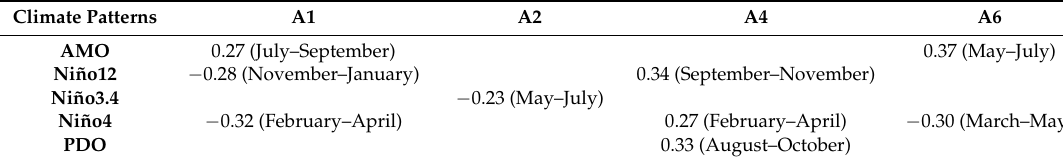
Table 1. Correlations of the identified climate patterns and the summer archetypes at 95% confidence level. The time period of the archetypes is from 1960 to 2014 and the time period of the climate patterns is from 1959 to 2013. The season in the parentheses indicates the season for climate patterns with the strong correlation.